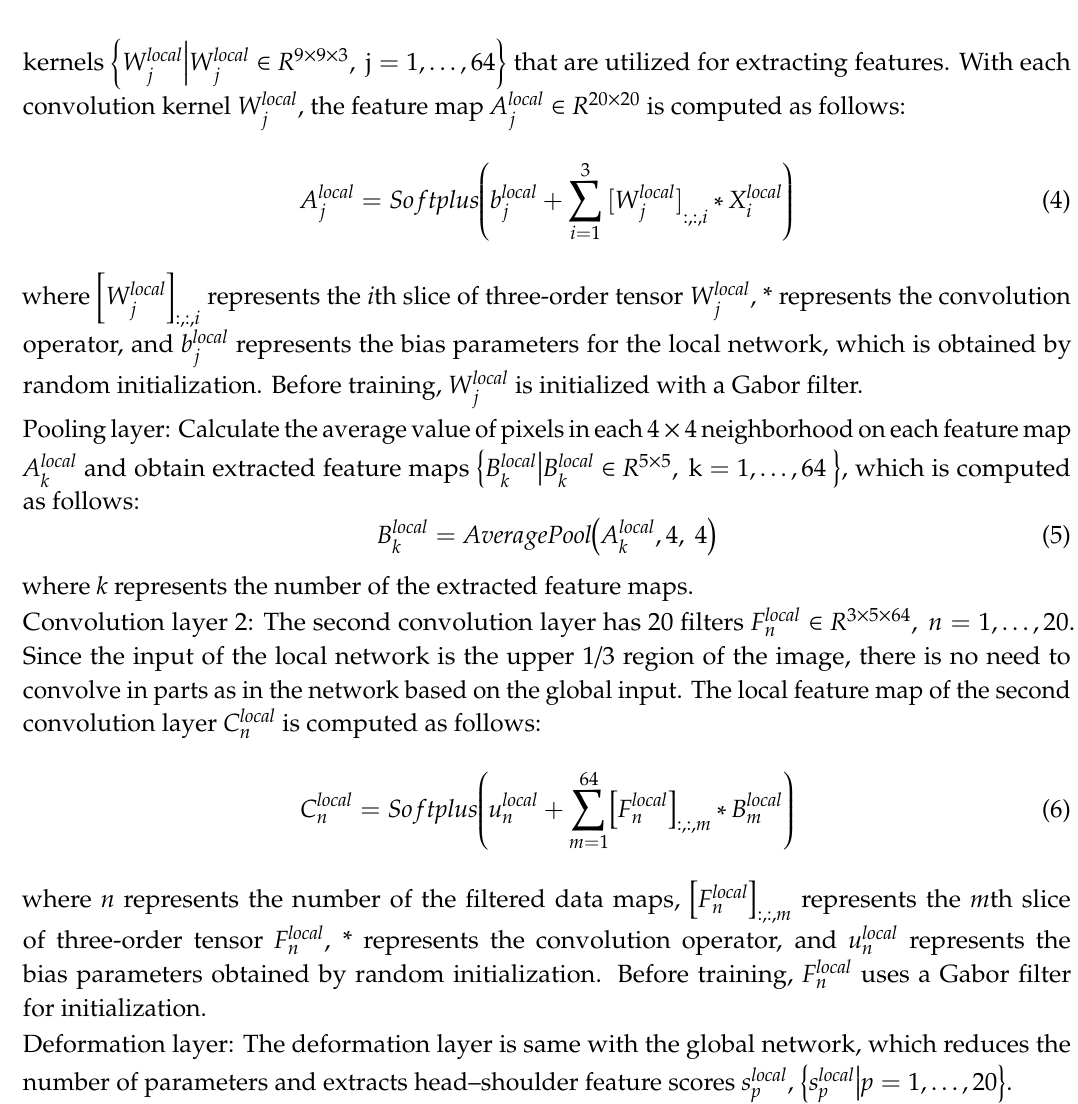
Classification layer: The visibility reasoning network [15] is used to estimate the label y local by learning the head–shoulder feature scores s local , which represents whether the upper 1 / 3 part p contains a pedestrian head–shoulder or